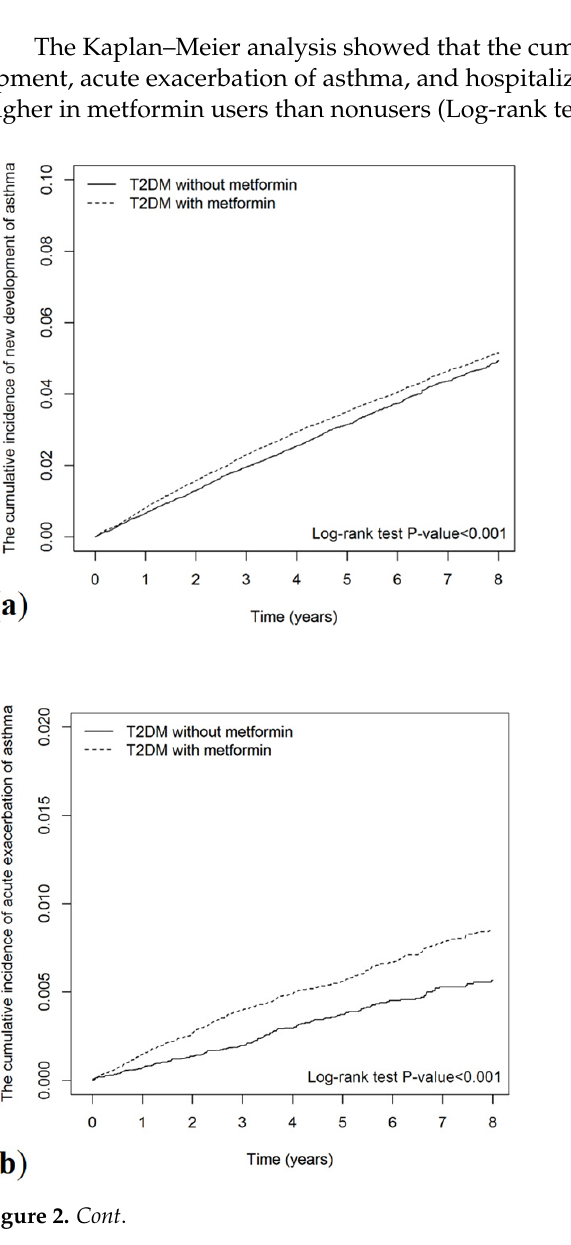
Figure 2. Cumulative incidences of ( a ) new development of asthma, ( b ) acute exacerbation of asthma, and ( c ) hospitalization for asthma for metformin users vs. nonusers. Table 3. Hazard ratios (HRs), and 95% confidence intervals (CIs) for outcome disease among the sampled patients. 3.3. Cumulative Duration of Metformin Use We observed the association between the cumulative duration of metformin use and the risk of asthma onset, exacerbation, and hospitalization for asthma (Table 4). Metformin use for more than 728 days was associated with significantly higher risks of asthma onset, exacerbation, and hospitalization for asthma than metformin nonuse (Table 4).